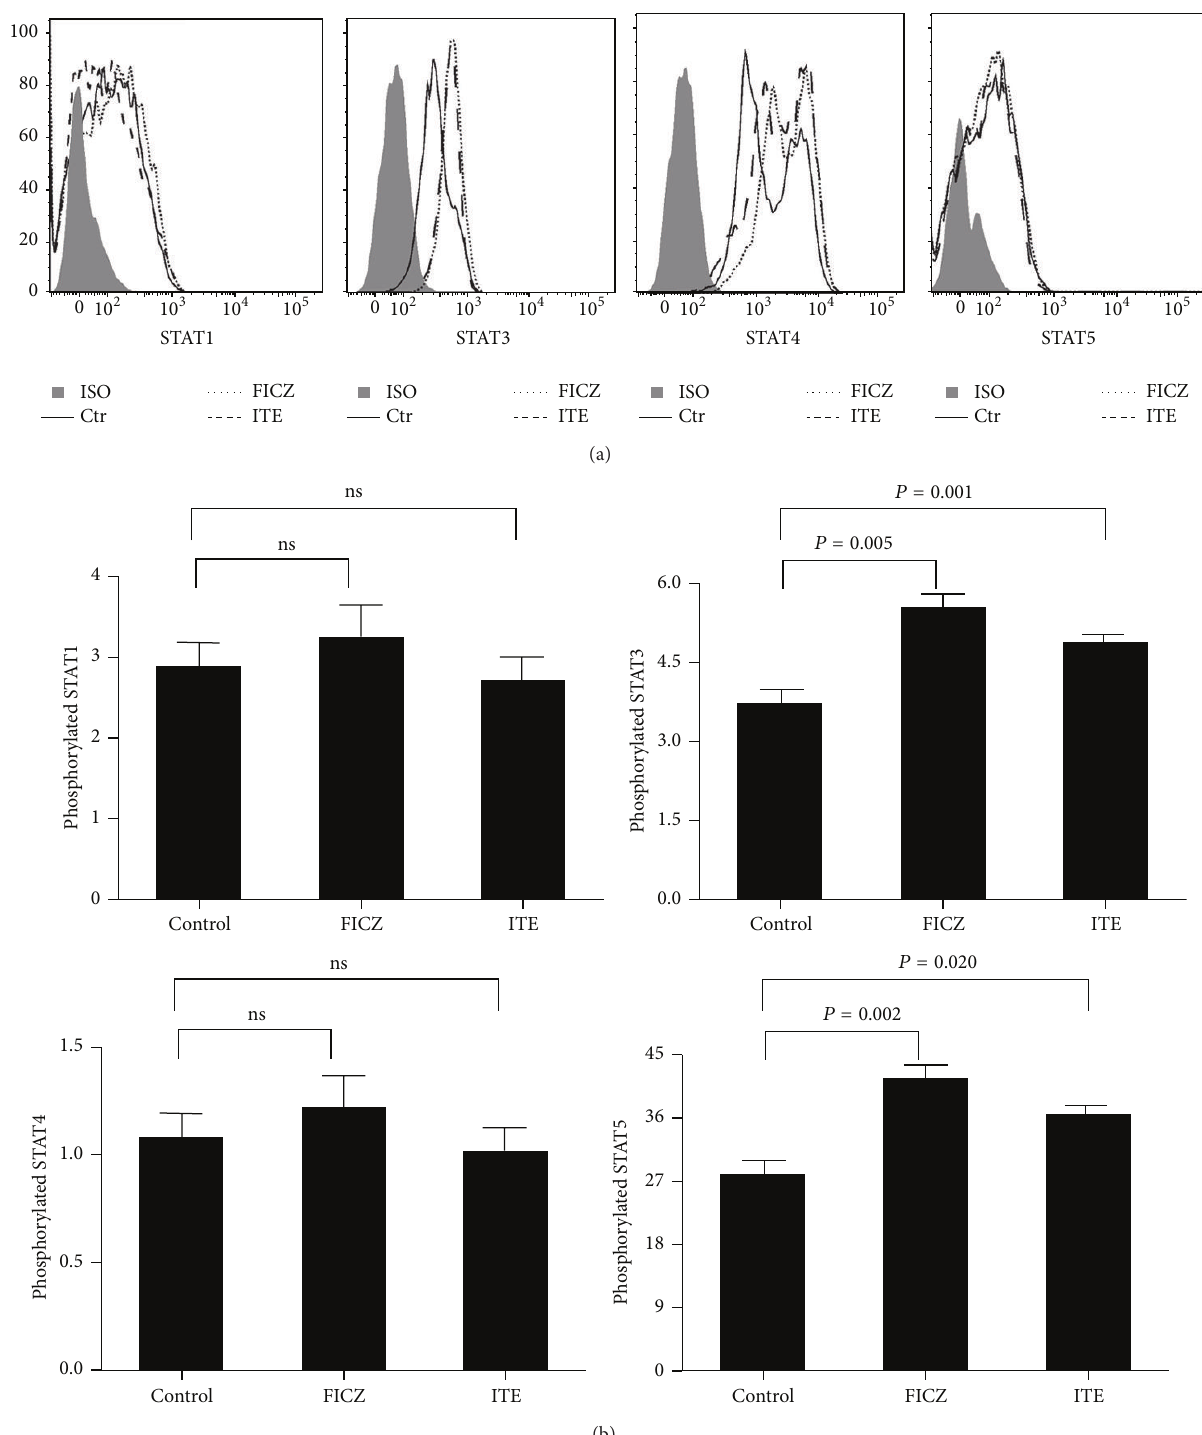
Figure 5: Effect of AhR activation by FICZ or ITE on phospho-STAT1, -3, -4, and -5 in CD4 + T cells. (a) CD4 + T cells from normal controls ( 𝑛 = 7 ) were stimulated with anti-CD3/CD28 and rIL-23 in the presence or absence of FICZ or ITE for 30 min. Intracellular phosphorylated STAT1, -3, -4, and -5 were analyzed by flow cytometry. A representative histogram from each group along with the isotype control is shown. (b) Statistical results of phosphorylated STAT1, -3, -4, and -5 in stimulated CD4 + T cells. Paired-sample t test for related samples was used for statistical analyses. The data are expressed as mean ±